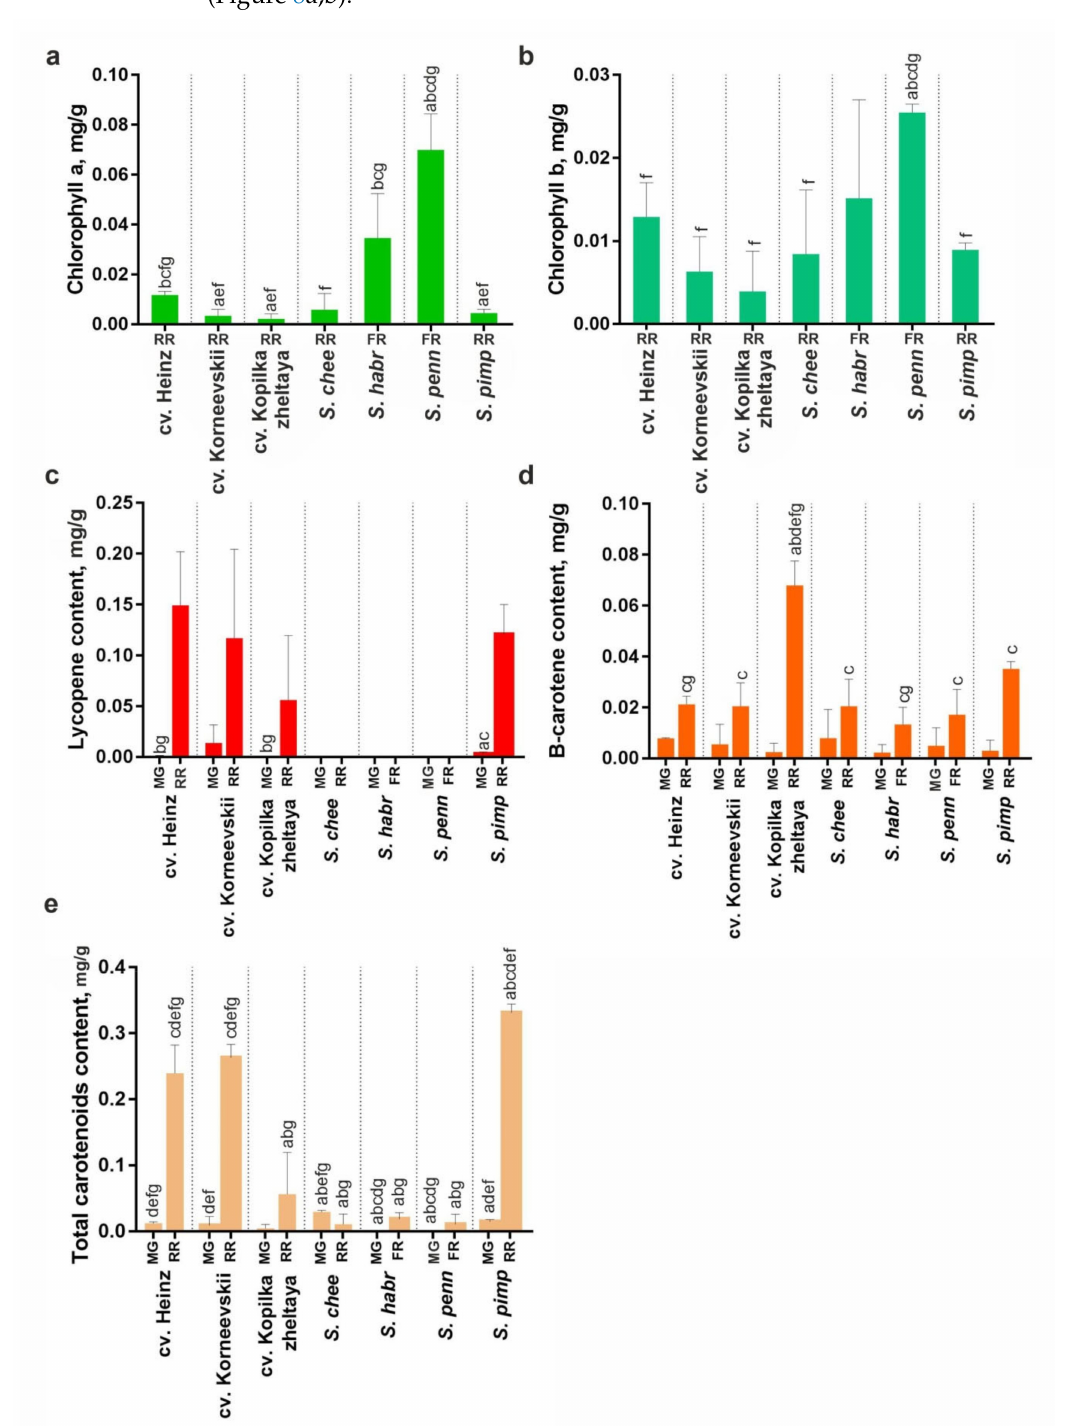
Figure 8. Chlorophyll ( a , b ) and carotenoid ( c – e ) content in MG and ripe fruit (RR in YF/RF accessions, FR in GF accessions) of S. lycopersicum (cv. Heinz, Korneevskii, Kopilka zheltaya), S. cheesmaniae LA0421 ( S. chee ), S. habrochaites LA2144 ( S. habr ), S. pennellii LA0716 ( S. penn ), and S. pimpinellifolium VIR1018 ( S. pimp ). Low-case letters above the bars indicate statistically significant differences ( p < 0.005) between pigment content in the same tissue of different